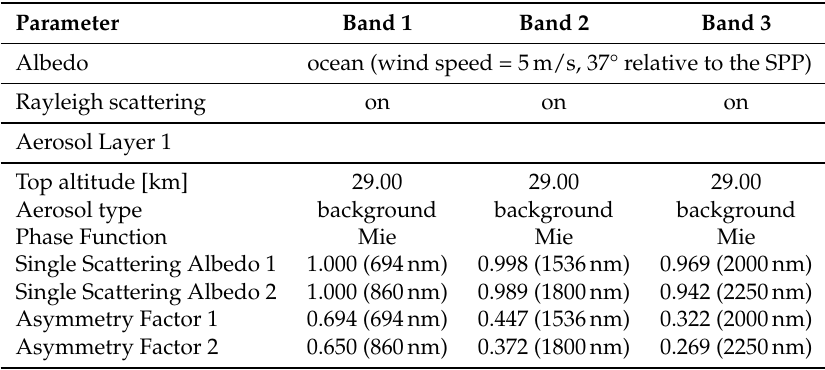
Table A7. Scattering parameters of scenario Rayleigh+Ocean glint